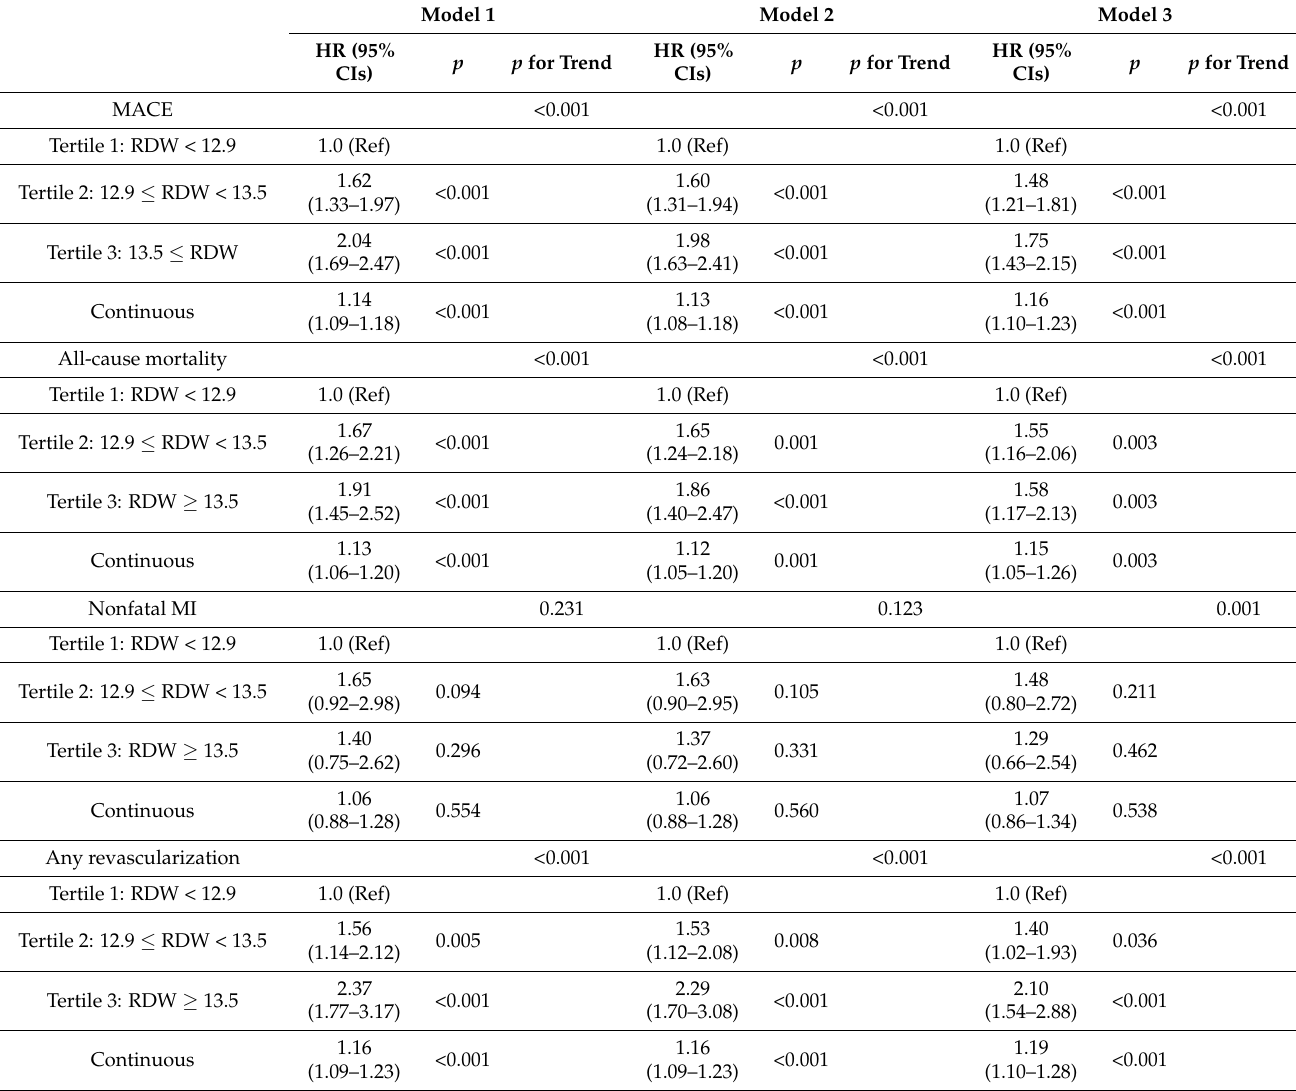
Table 3. The association between RDW and